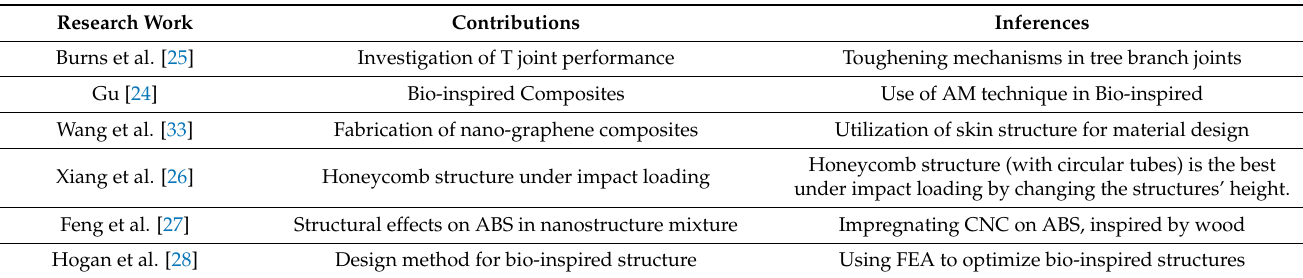
Table 2. Review of Materials used in Bio-inspired